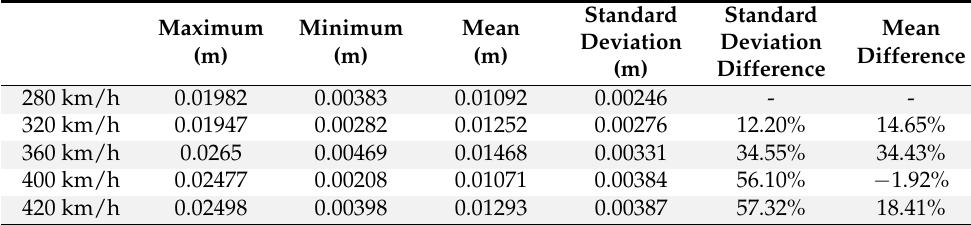
Table 4. Statistical results of vertical displacement of the contact strip passing through tunnel at different speeds.